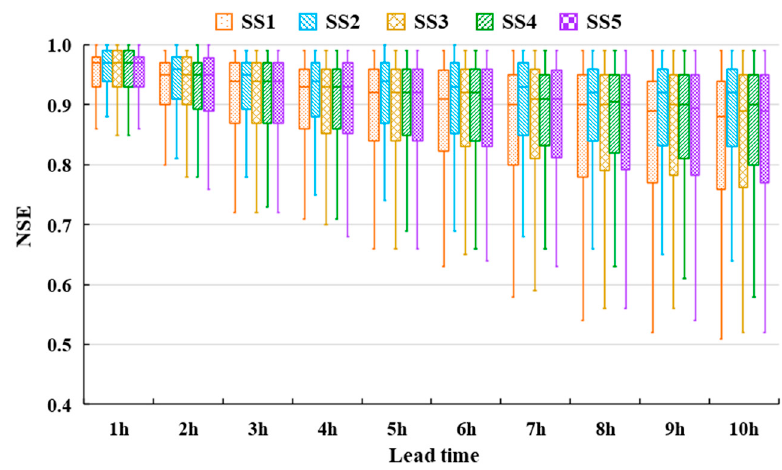
Figure 10. Nash–Sutcli ff e coe ffi cient of e ffi ciency (NSE) for di ff erent sample sets at 1–10-h lead-time.